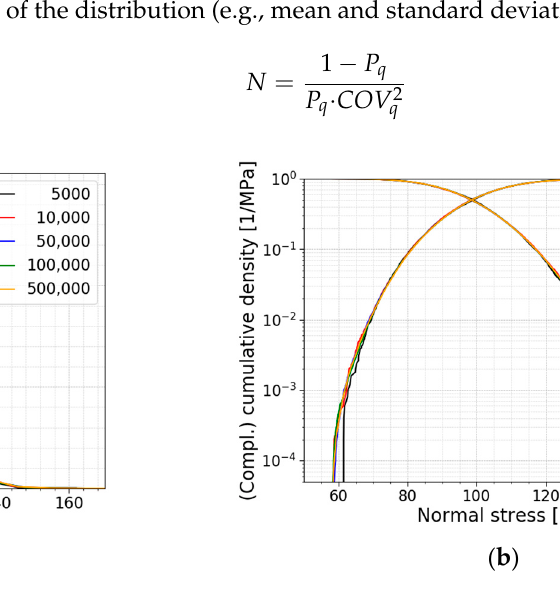
Figure 12. ( a ) PDF and ( b ) CDF of the convergence study. Table 3. Simulations needed for convergence at a given P q